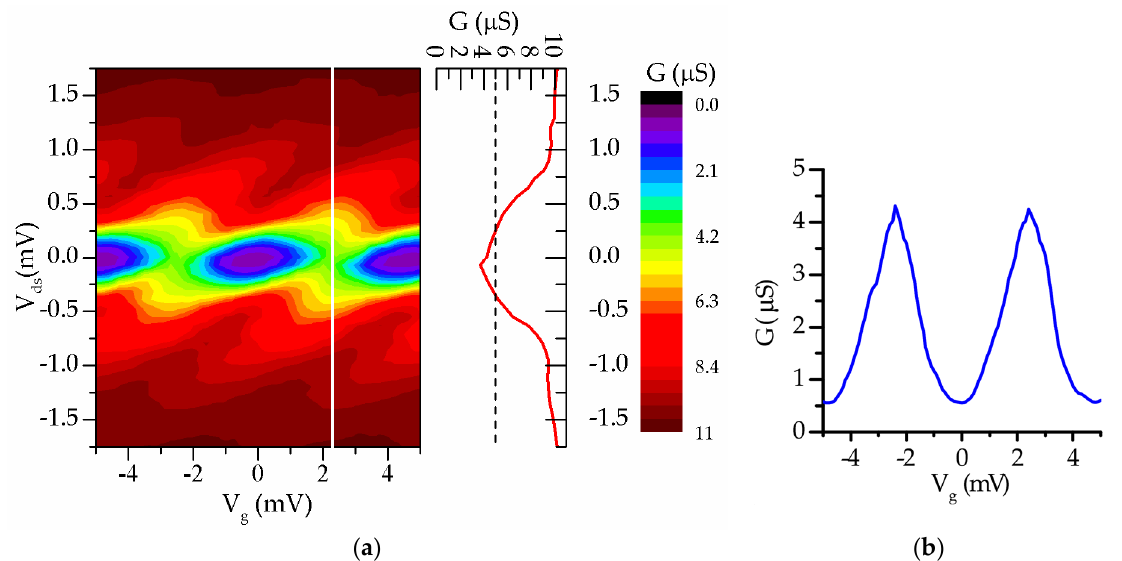
Figure 3. Electrical characterization of Pt ‐ Al 2 O 3 ‐ Pt SET prepared using nine ALD cycles of Al 2 O 3 (~1 nm) with no post fabrication treatments: ( a ) Coulomb diamond plot and G ( V ds ) dependence for V g = 2.3 mV (a peak of Coulomb blockade oscillation). Note that zero bias conductance G ( V ds = 0 mV) is just slightly below the G 0 /2 value (indicated by the dashed line) expected from orthodox theory; ( b ) Coulomb Blockade Oscillations (CBOs) for V ds = 0 mV. T = 0.3 K, measurements were performed